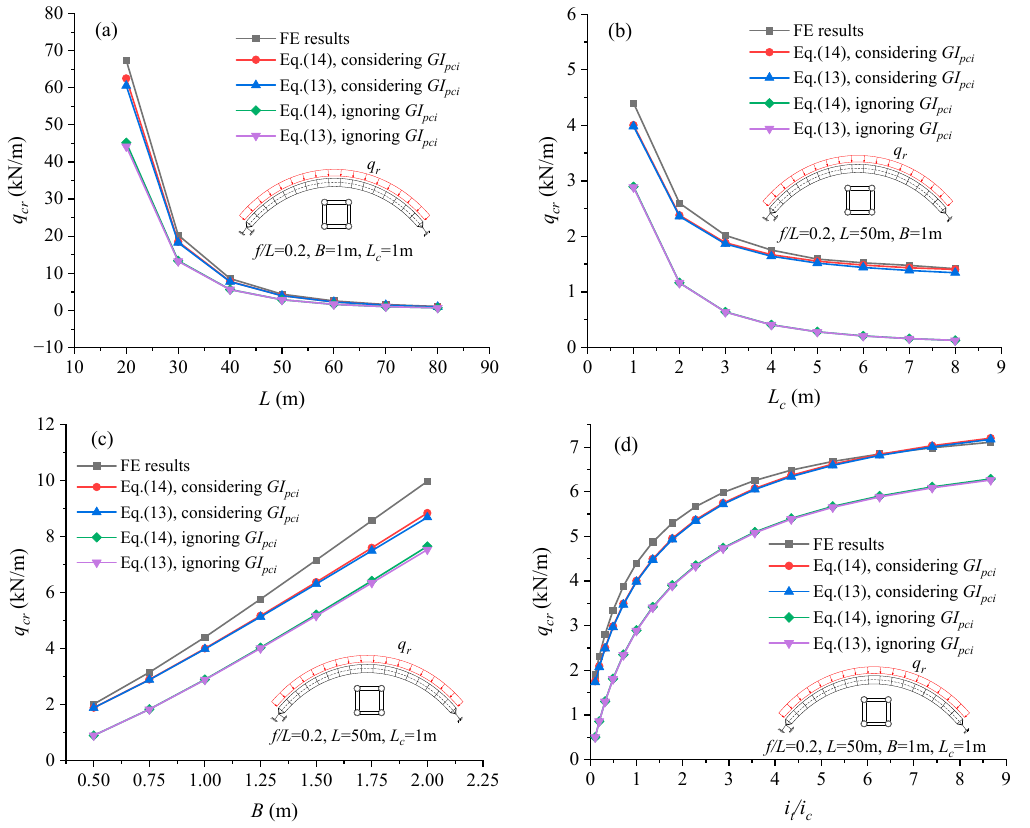
Figure 9. Comparison of buckling loads between FE and theoretical results for the pin-ended Vierendeel truss arches with varying ( a ) spans, ( b ) segmental lengths, ( c ) sectional side lengths, and ( d ) transverse-to-chord member sti ff ness ratios . Table 1. Increment of the average buckling load over the considered dimensions for the pin-ended Vierendeel truss arches considering GI pci with respect to that ignoring GI pci .